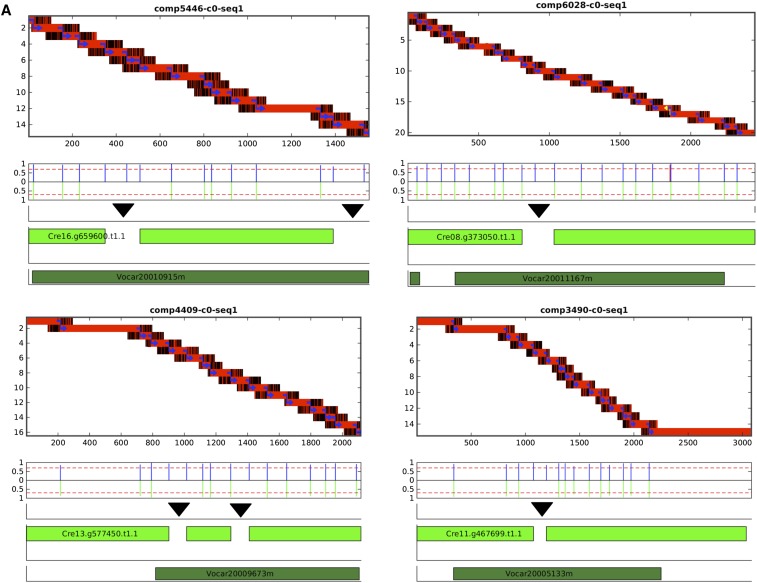
Graphical summary of analysis of Trinity objects. The ‘frame’ for all data are the sequence of the Trinity object (numbers on x-axis of top graph). At top is the result of analysis of genomic reads aligned to the Trinity object. (A) The red/black bars are alignment islands, where red indicates identical sequence to Trinity and black non-identical sequence. The blue joining arrows indicate high-scoring splice junctions (if detected, junctions on the opposite strand are in yellow). Below is a quantitative trace of splice junction locations and scores (standardized to the maximum possible score of ∼15; the cutoff value for acceptance of 11 is illustrated by the red line). The blue lines are splices in our model; green lines below are splices from the reference transcript model aligned to the Trinity object. Red lines indicate splice junctions on the opposite strand in the Trinity sequence. The green bars indicate regions of alignment (HSPs) to the specified Phytozome reference transcript. The black triangle indicates that the gap in the Blastn alignment to the Phytozome transcript model is the approximate location of putatively spliced-out N-islands in the reference. The bottom graph indicates the positions of Blastx alignment to the Volvox proteome. (A) Typical cases for ‘bridging’ Trinity objects. In these four cases the entire set of consensus islands are joined into one ‘connected island’ by same-sense splices. (B) Rare aberrant cases where the Trinity object is due to ‘track-crossing’ in silico, and contains regions of two distinct reference transcripts (top two examples), or where splice detection fails even on the same reference transcript (bottom two examples). In these cases there are multiple connected islands (gray outlines).